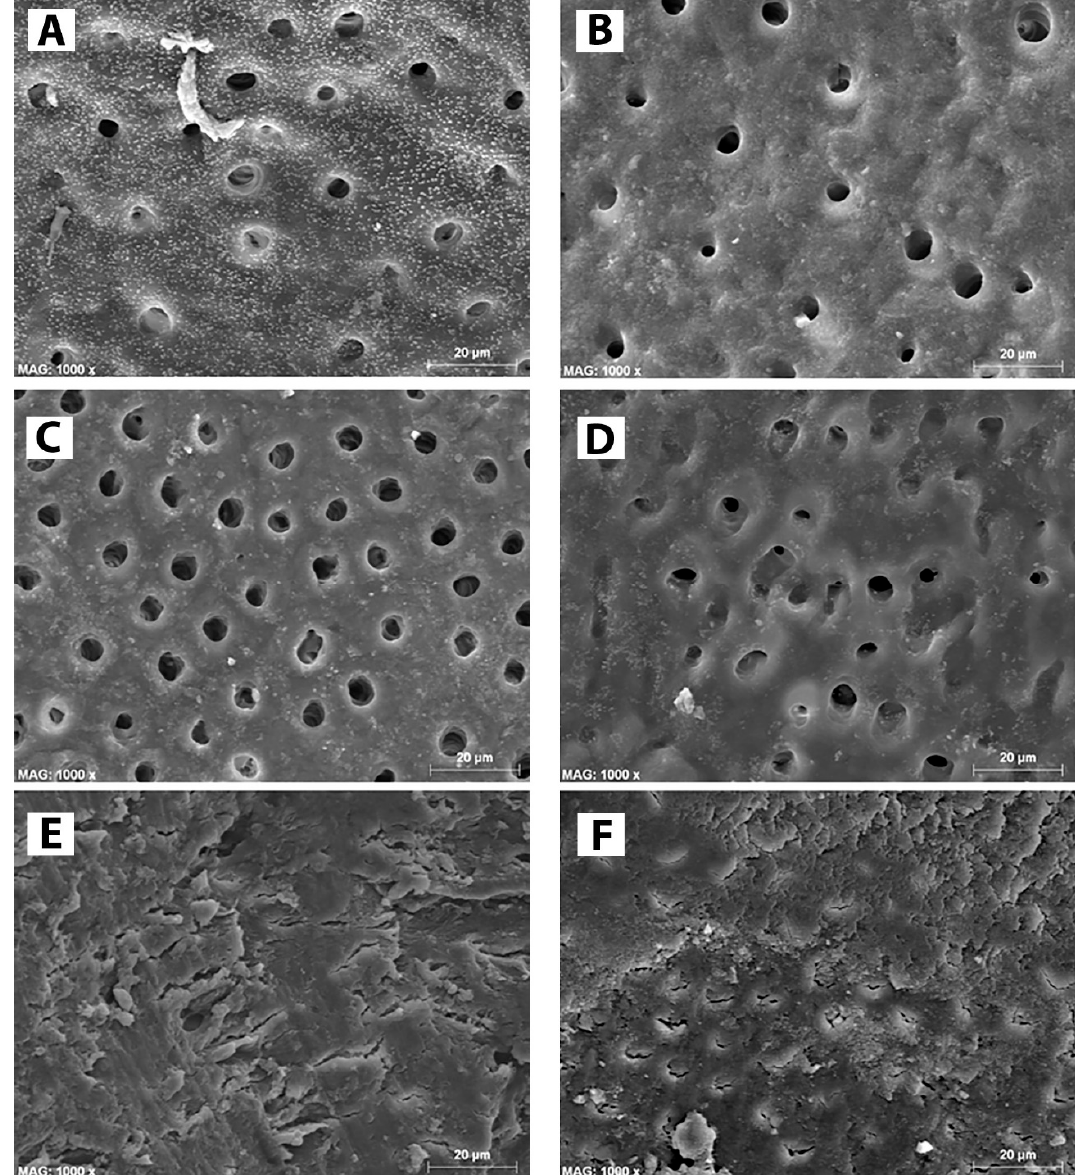
Figure 2. SEM micrographs of root canal dentin treated with the irrigation solutions tested in this study. ( A ) note the e ff ect of BioAKT on the coronal part of the root canal dentin where the smear layer was totally removed and most of the dentinal tubules exposed. ( B ) The same situation was observed on the middle part of the root canal after treatment with BIOAKT. EDTA was able to remove the smear layer and expose dentinal tubules both at coronal dentin ( C ) and middle dentin ( D ). ( E ) The control irrigant (PBS) had no removal e ff ect on any part of the root canal dentin; note the presence of a compact smear layer with no dentinal tubules exposed. ( F ) Representative image of coronal and middle dentin treated with NaOCl showing shallow removal e ff ect on the smear layer. Note that most of the root surface remined covered by a porous organic smear layer with very few dentinal tubules, which were only partially exposed.